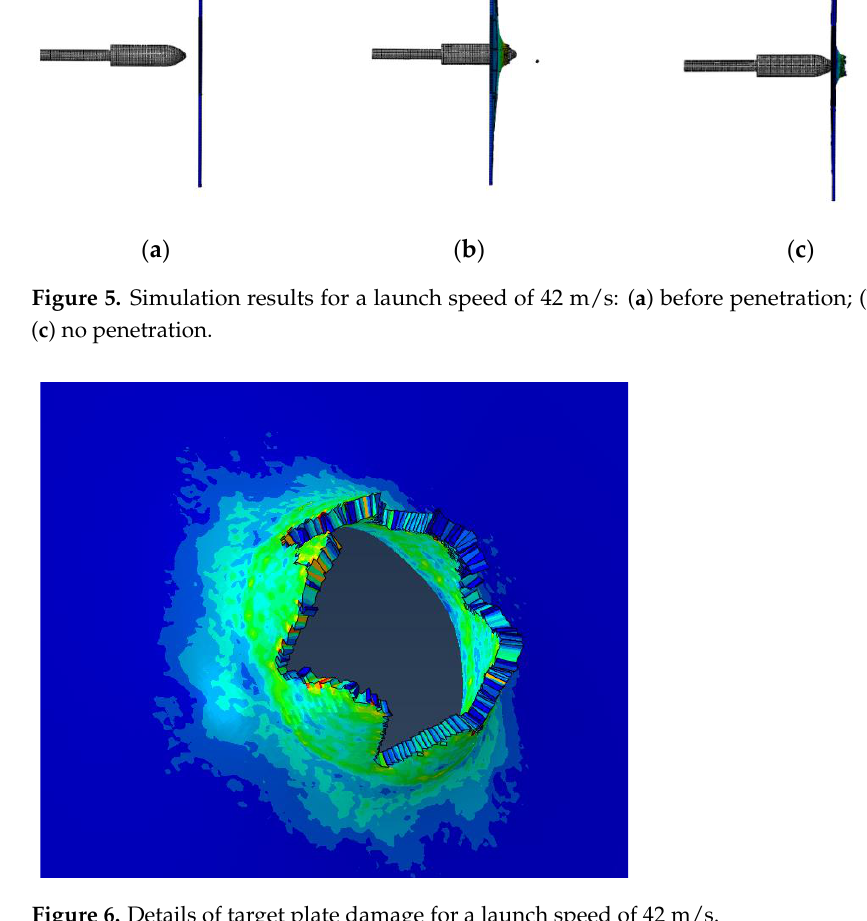
(b) Figure 7. Simulation results of 50 m/s initial velocity: ( a ) simulation results side view, and ( b ) embed details. When the launching speed of the harpoon is 56 m/s, the harpoon penetrates the target plate, as shown in Figure 8. The harpoon pierces the target plate, which forms petal- shaped cracks at the hole, as shown in Figure 9. The diameter of the simulated hole is 20.1 mm.